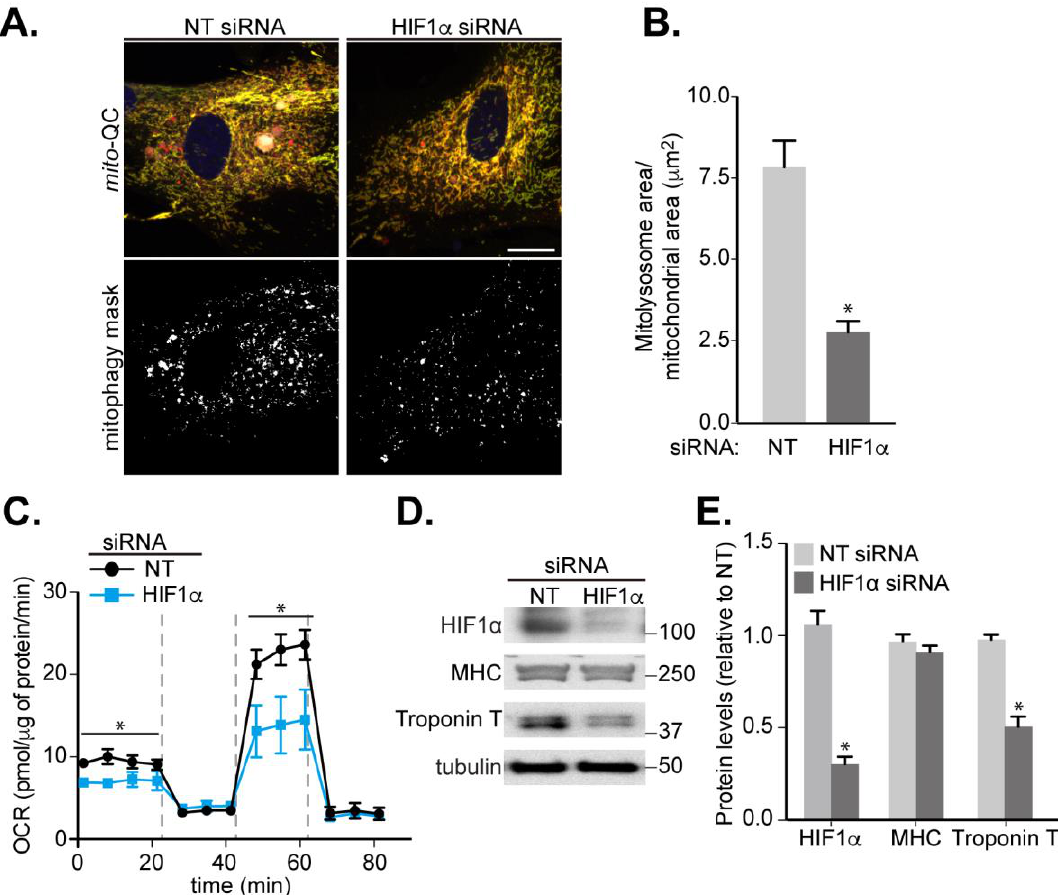
FIGURE 5: Involvement of HIF1α in mitophagy and cardiomyocyte differentiation. H9c2 cells were cultured in differentiation medium for 7 days. (A) Representative images of mito -QC H9c2 cells transfected with non- targeting (NT) siRNA or HIF1α siRNA at day 4 of differ